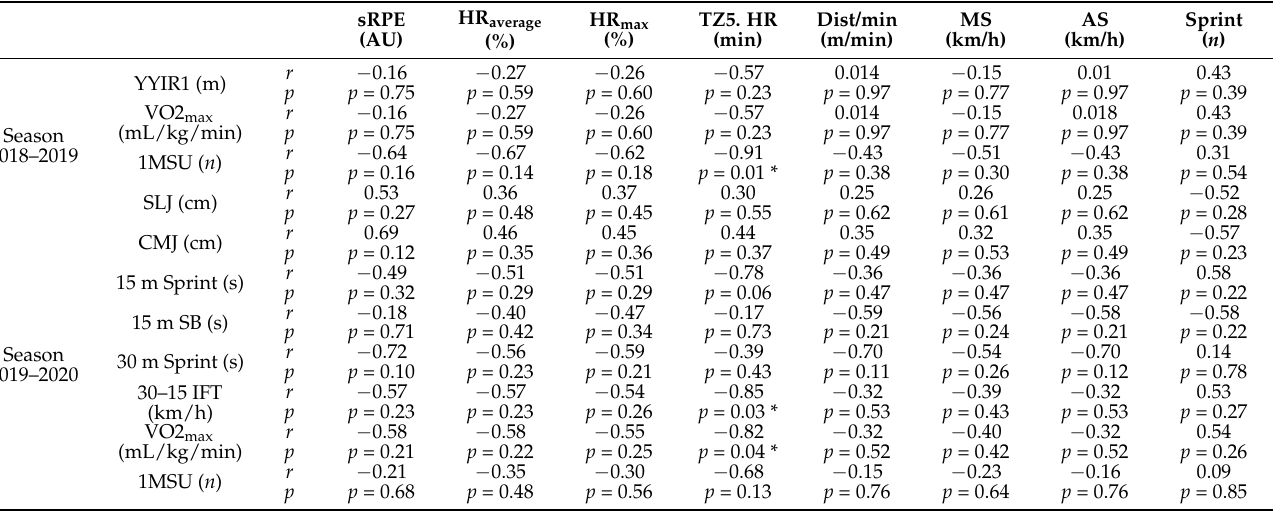
Table 6. Correlation between performance variables, locomotor demands, and physical fitness assessment for selected futsal